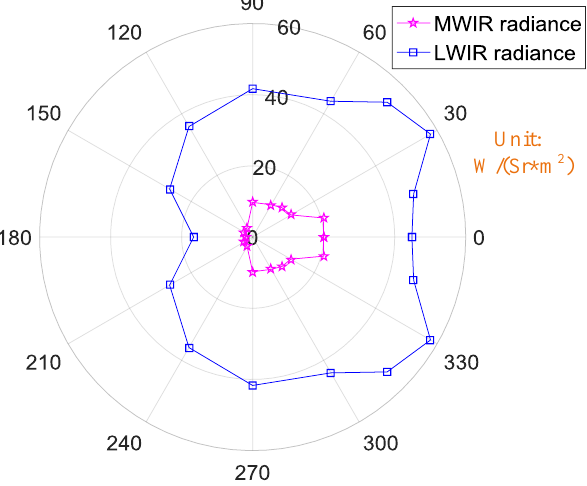
Figure 11. Orientation map of the engine’s radiance in different IR bands.